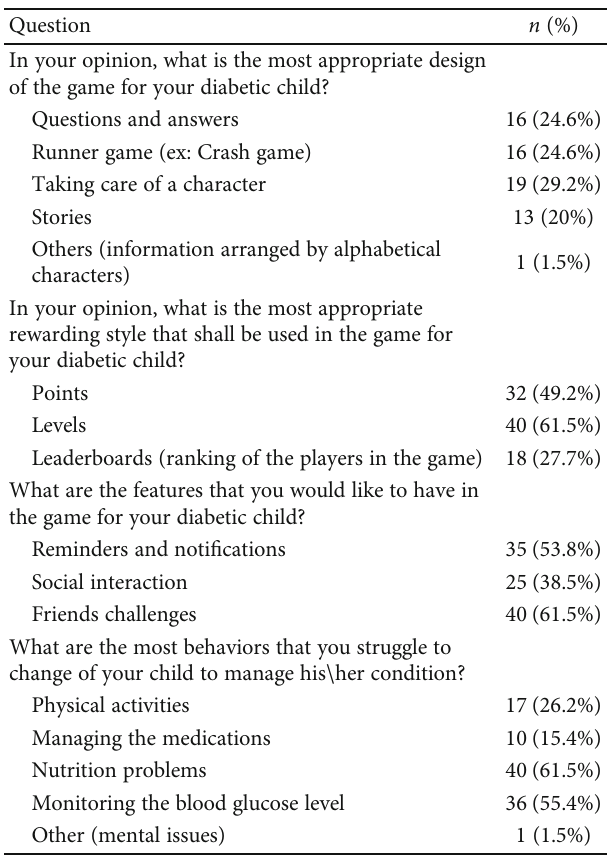
Table 3: Opinion of caregivers of children with diabetes about the design of the screens of the mobile application ( n = 65 ).